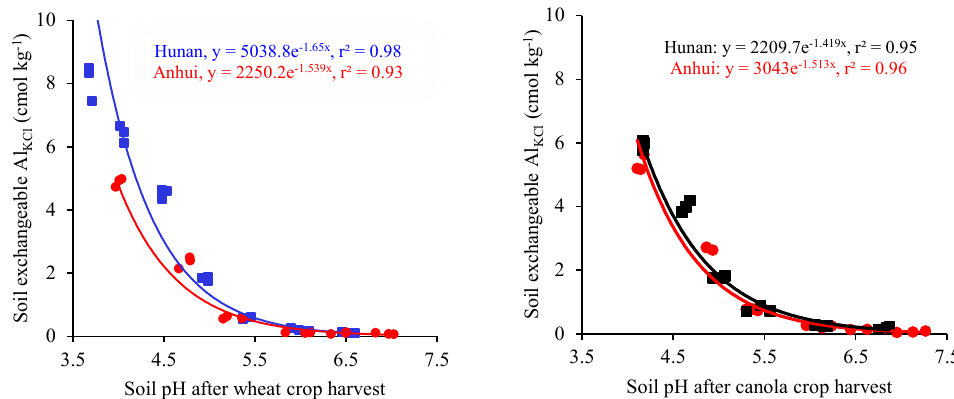
Figure 1. Relationship between soil pH and KCl extractable Al (cmolkg − 1 ). The fitted equations were significant at P